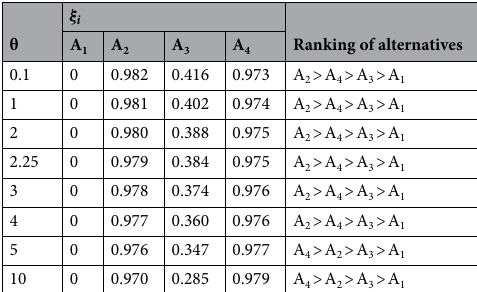
Table 6. The sensitivity analysis changing θ value.